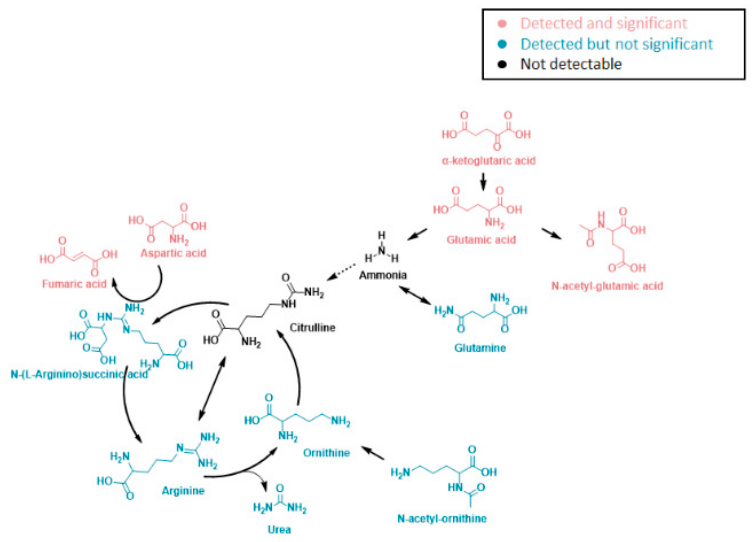
Figure 13. Arginine Metabolites Affected in Their 13 C-Enrichment from Glucose by NAT1 KO in Breast Cancer Cells. Metabolites detected in the arginine biosynthesis pathway. Metabolites in black were not detected in this study, while the isotopologues of metabolites in pink showed significant abundance changes from NAT1 KO. Isotopologues of the metabolites in blue did not show significant abundance changes.